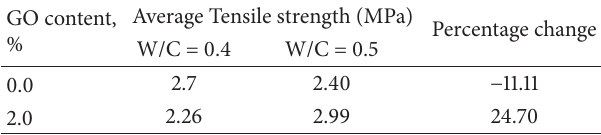
Figure 15: FE-SEM images of cement mortar containing 2.0wt% GO at a scale of 15 𝜇 m. Table 5: The comparison between the tensile strength results of samples at the different w/c